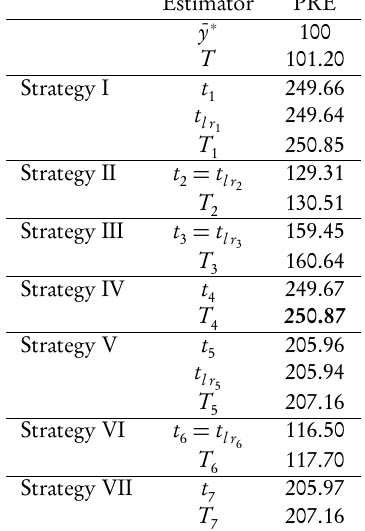
Percentage relative efficiency (PRE) of the proposed estimators with respect to ¯ y ∗ using simulation.